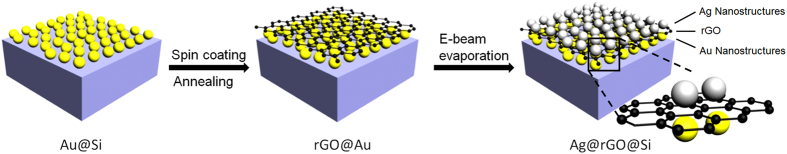
Schematic of the fabrication process for the hybrid system as a G-SERS substrate.